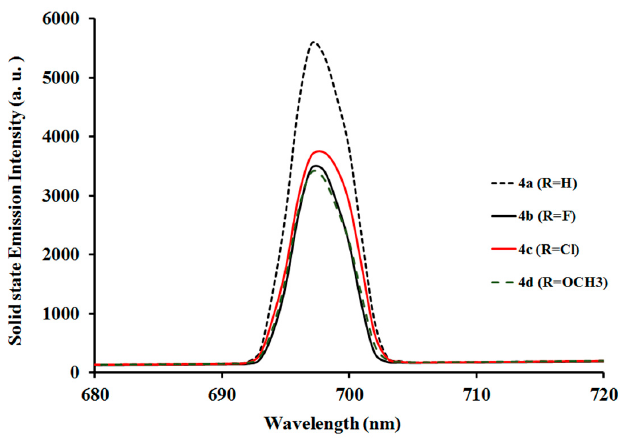
Figure 9. Solid state phosphorescence emission spectra of (Ir( 4a – d ) 3 ) at λ ex = 350 nm at RT.